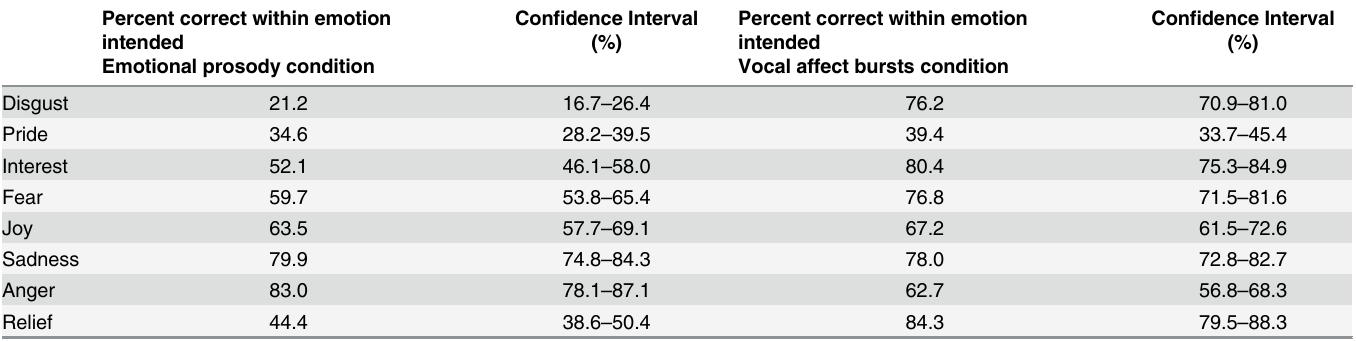
Table 3. Results from binomial